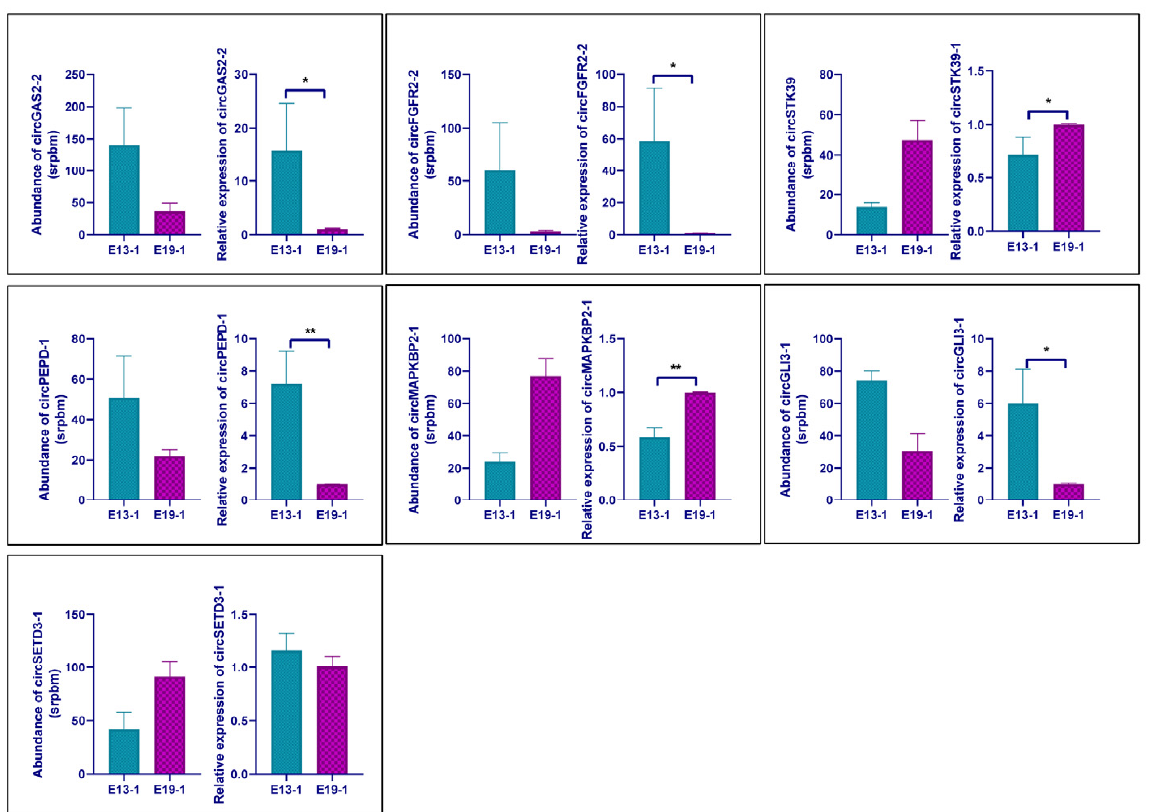
Figure 4. qRT-PCR verification of the differentially expressed circRNAs. The values are shown as means ± SEM. * p < 0.05; ** p < 0.01.